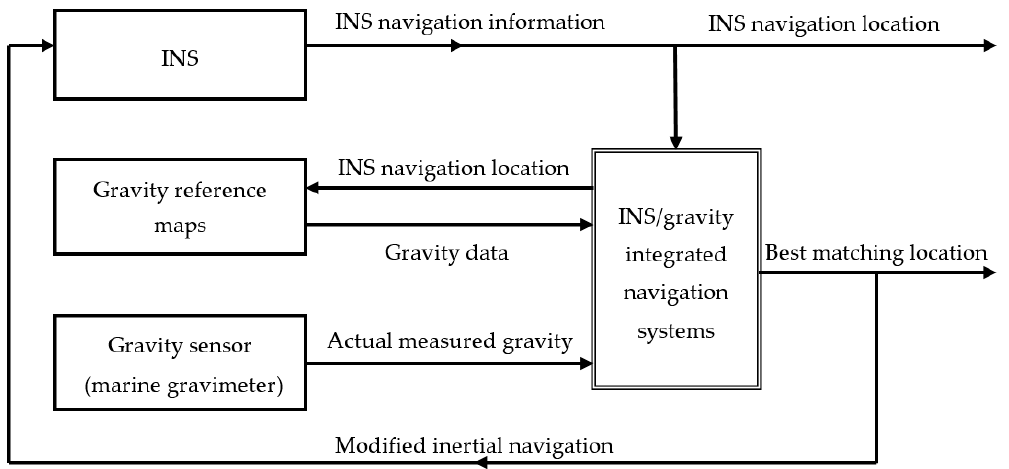
Figure 1. The basic principle of gravity matching-aided navigation.